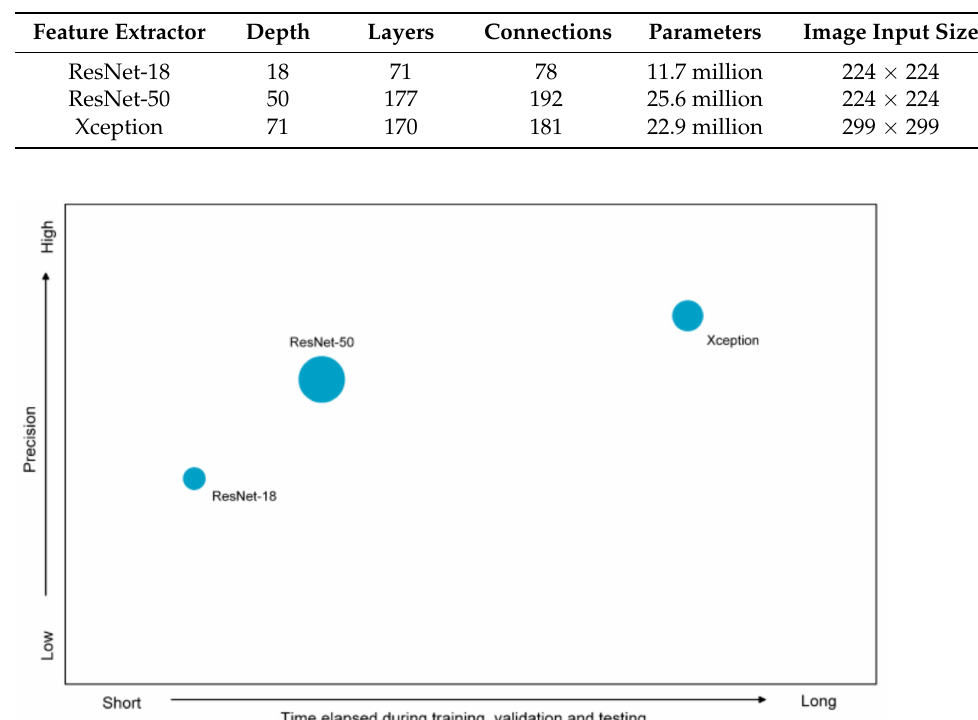
Table 5. Important properties of ResNet-18, ResNet-50, and Xception.